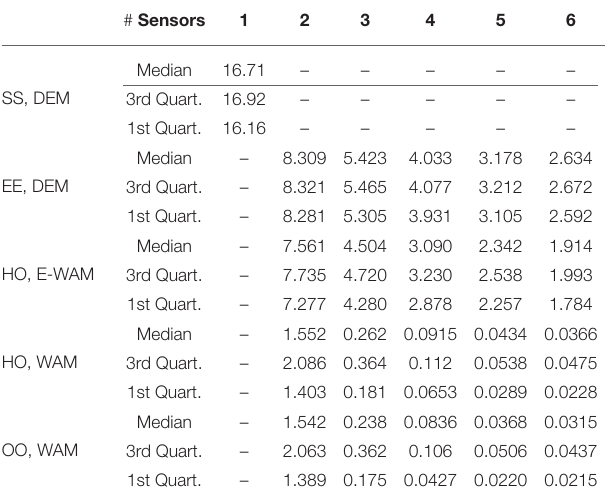
TABLE 2 | Average segment error as a percent of the range of motion, normalized over all of the deflection modes used for evaluation of performance.